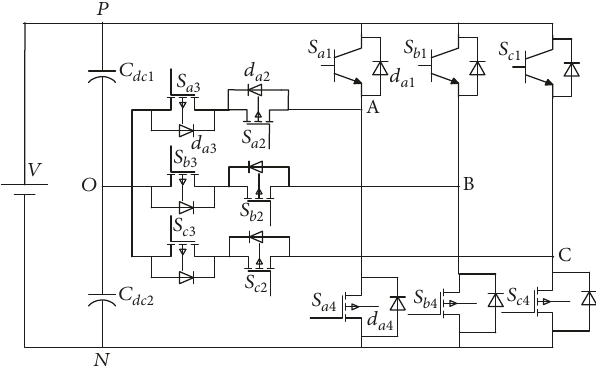
Figure 6: The proposed hybrid T-type inverter.